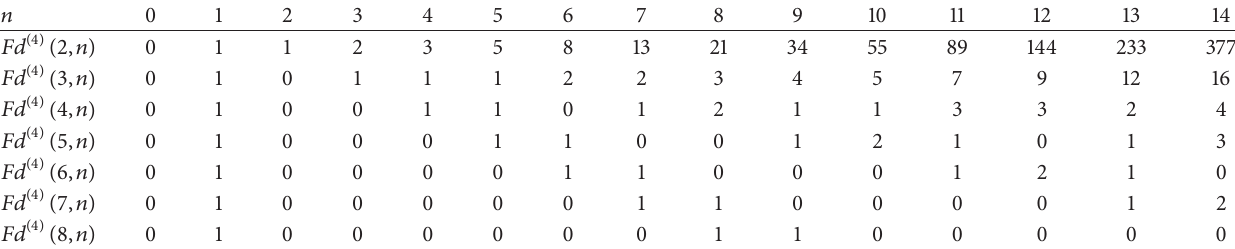
Table 4: The 𝑛 th distance Fibonacci numbers 𝐹𝑑 (4) (𝑘,𝑛)